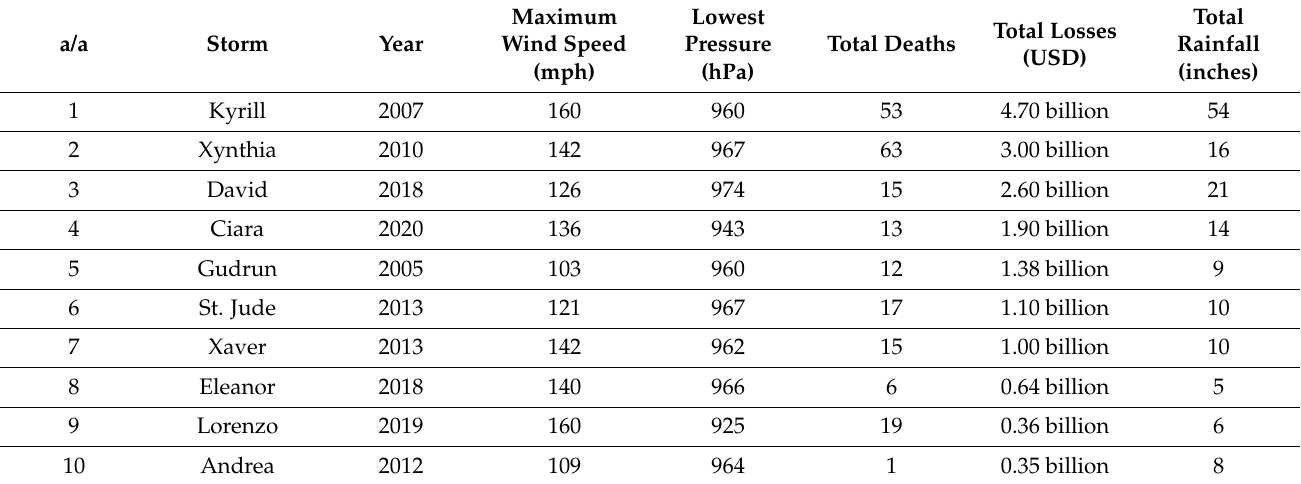
Table 4. The list of costliest storms in Europe since